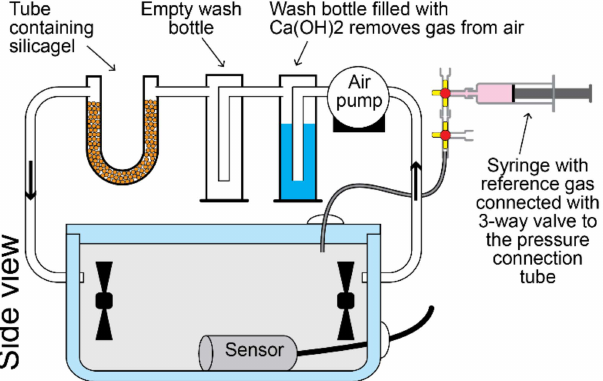
Figure 3. Setup to calibrate a CO 2 sensor and the circuit to remove ambient CO 2 inside the box.